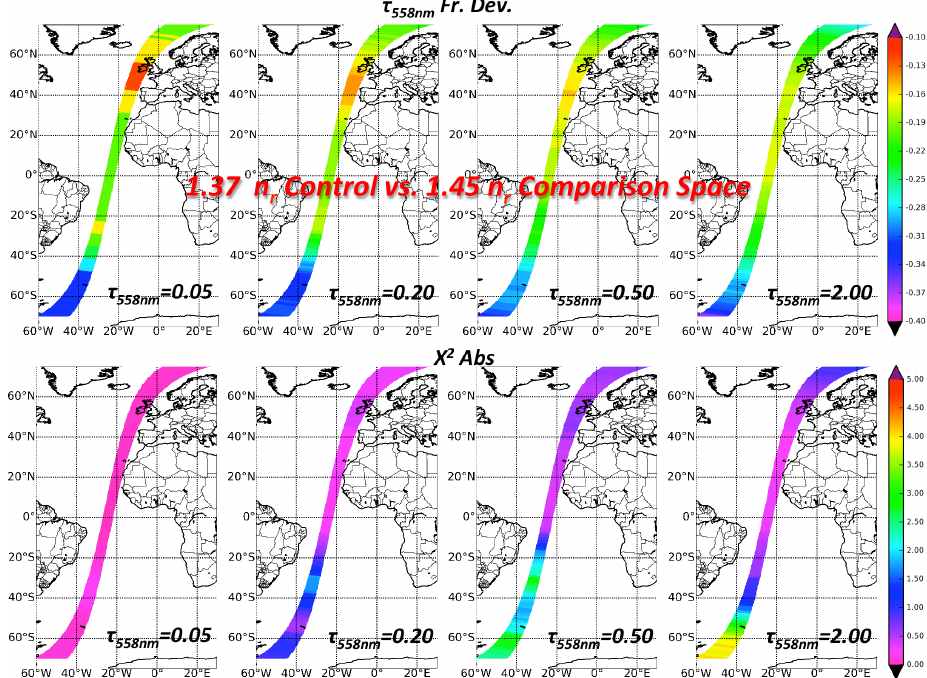
values for the lowest residual re- abs